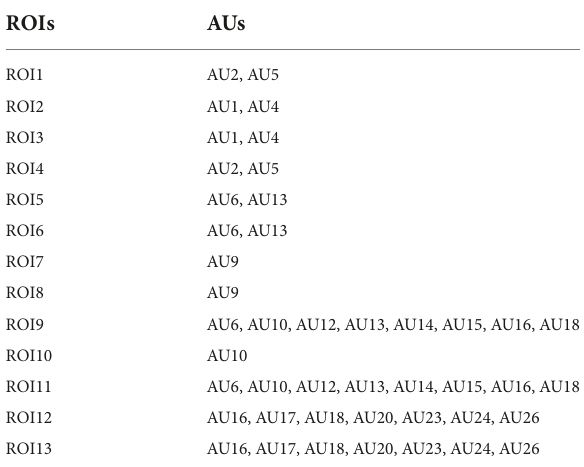
TABLE 1 Thirteen ROIs and corresponding action unit (AU) information.